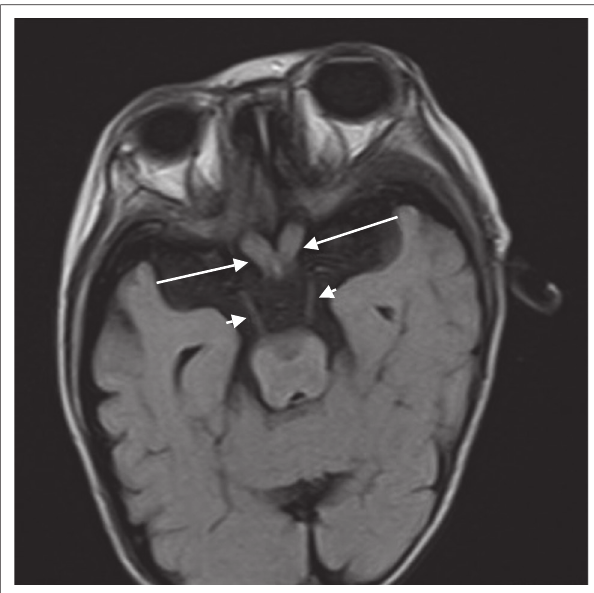
FIGURE 1: T2 FLAIR image of patient 1. Bilateral pre-chiasmatic optic nerve enlargement (arrows) as well as thickening of both cranial nerves IV (arrowheads).